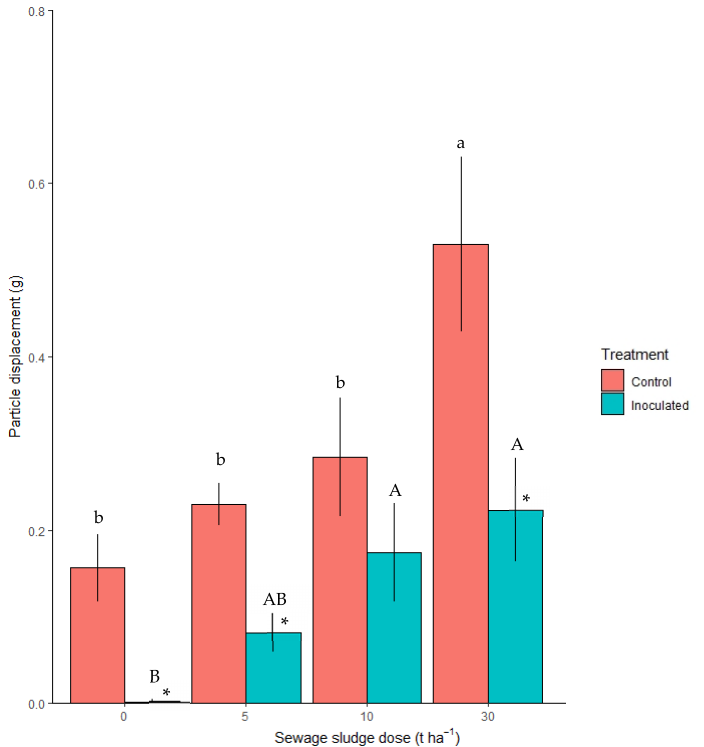
Figure 4. Sediment displaced (g) following wind simulation at a constant speed of 18 m s − 1 for one minute. Lowercase letters indicate significant differences among control treatments at the different SS doses, while capital letters indicate significant differences among inoculated treatments at the different SS doses. * indicates statistically significant differences between the control and the inoculated treatment inside the sewage dose considered.